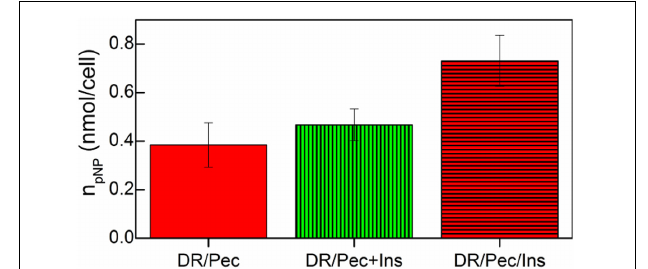
FIGURE 5 | hMSC cultures grown for 24h on reference DR/Pec surfaces (A) and on DR/Pec/Ins surfaces obtained by irradiation of DR/Pec films